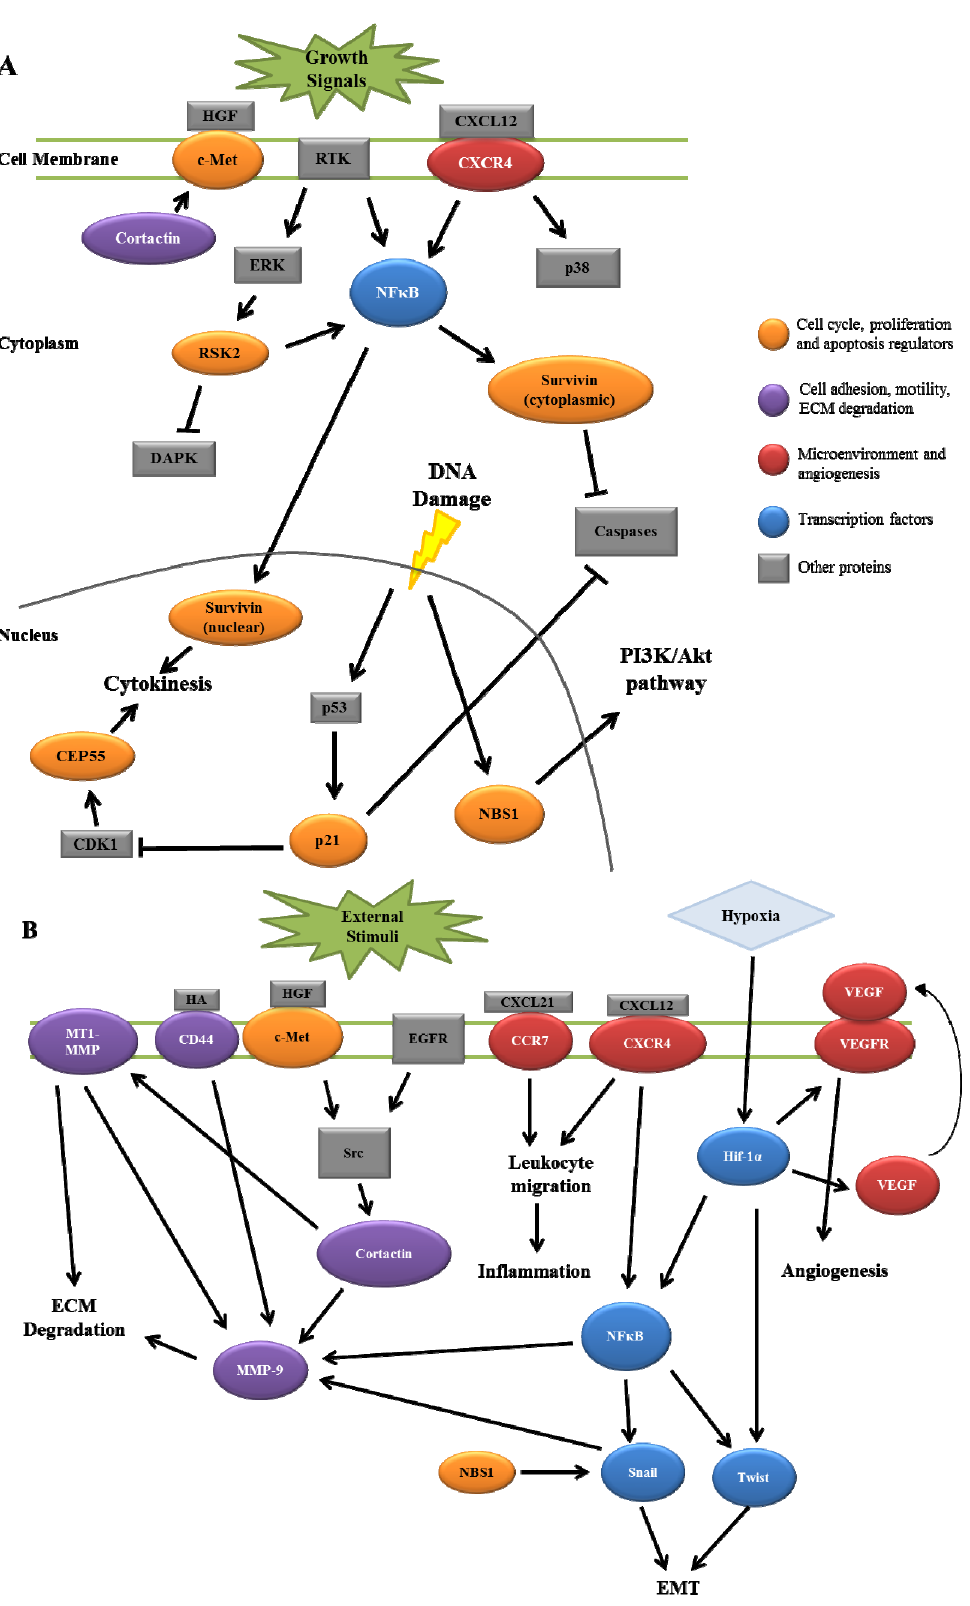
Figure 1. Potential interactions between recently identified biomarkers involved in HNSCC lymph node metastasis. (A) Putative interactions between proteins involved in cell cycle regulation, cell proliferation and apoptosis. (B) Potential interactions highlighted for mediators of cell motility, adhesion, ECM degradation and tumor